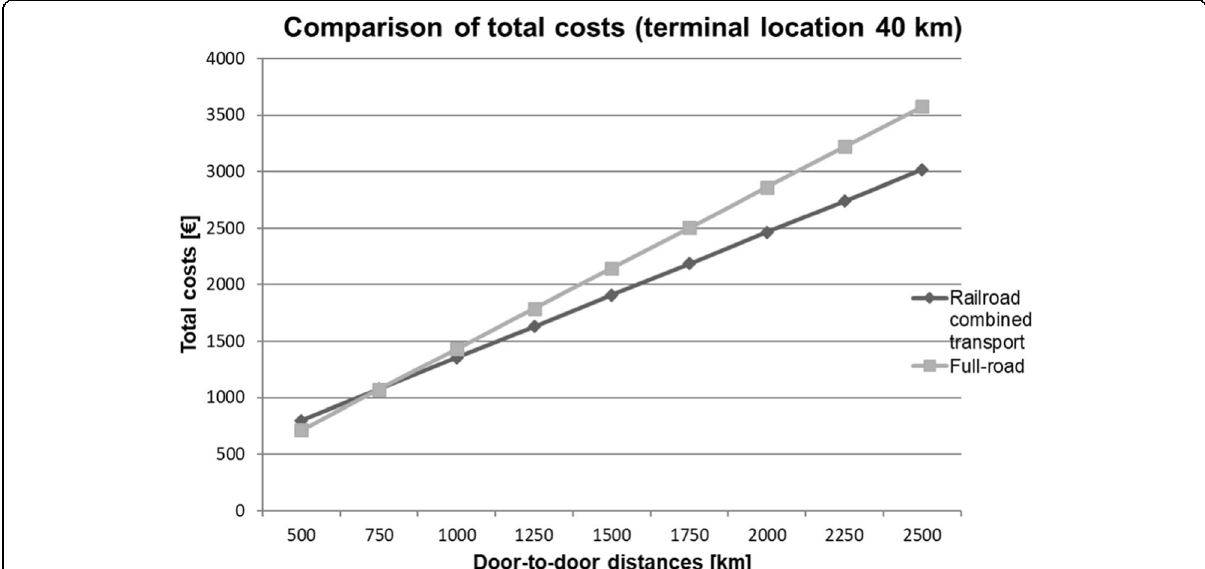
Fig. 14 Comparison of the total costs as a function of the distance between the origin and destination (terminal location: 40 km; related to the transport of one standard ITU 40 ′